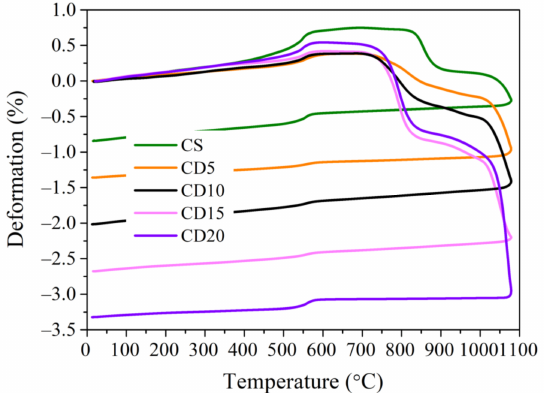
Figure 6. Dilatometric curves of ceramic bodies fired up to 1080 ◦ C.